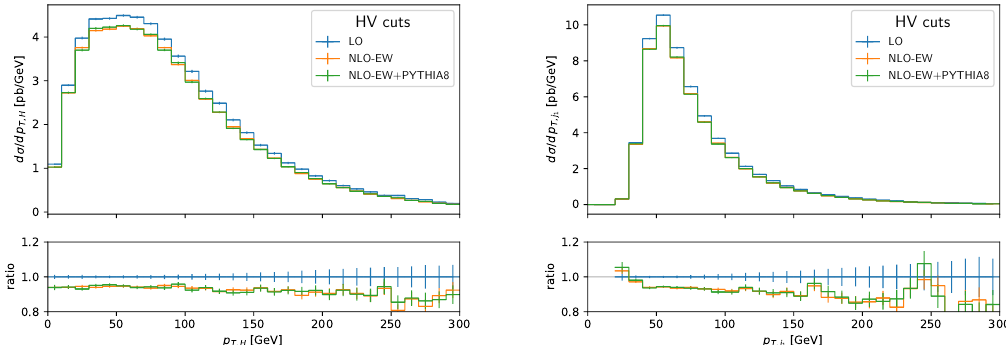
Figure 8 . Transverse-momentum distribution of the Higgs boson (left) and transverse momentum of the hardest tagging jet (right) at LO (blue), NLO-EW (red), and NLO-EW+PS (green) accuracy within the HV cuts of eqs. (3.9)–(3.10). The ratios of the NLO-EW+PS and the NLO-EW to the LO results are shown in the respective lower